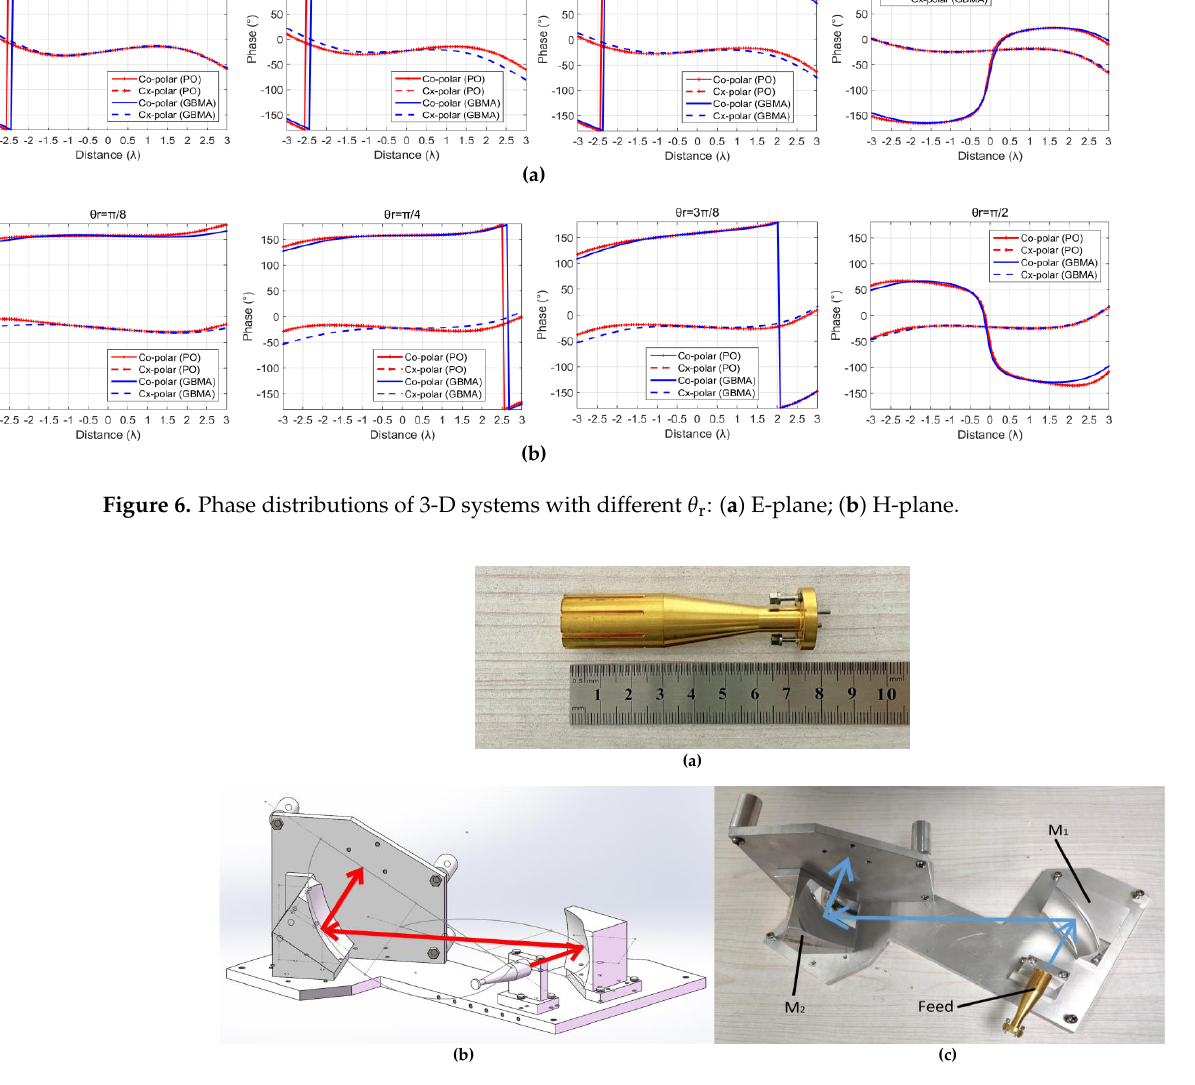
Figure 7. Prototypes of the corrugated horn and the fabricated quasi-optical systems with 𝜃 r = 𝜋/2 : (a) the corrugated horn; (b) the system in Solidworks; (c) the fabricated system.